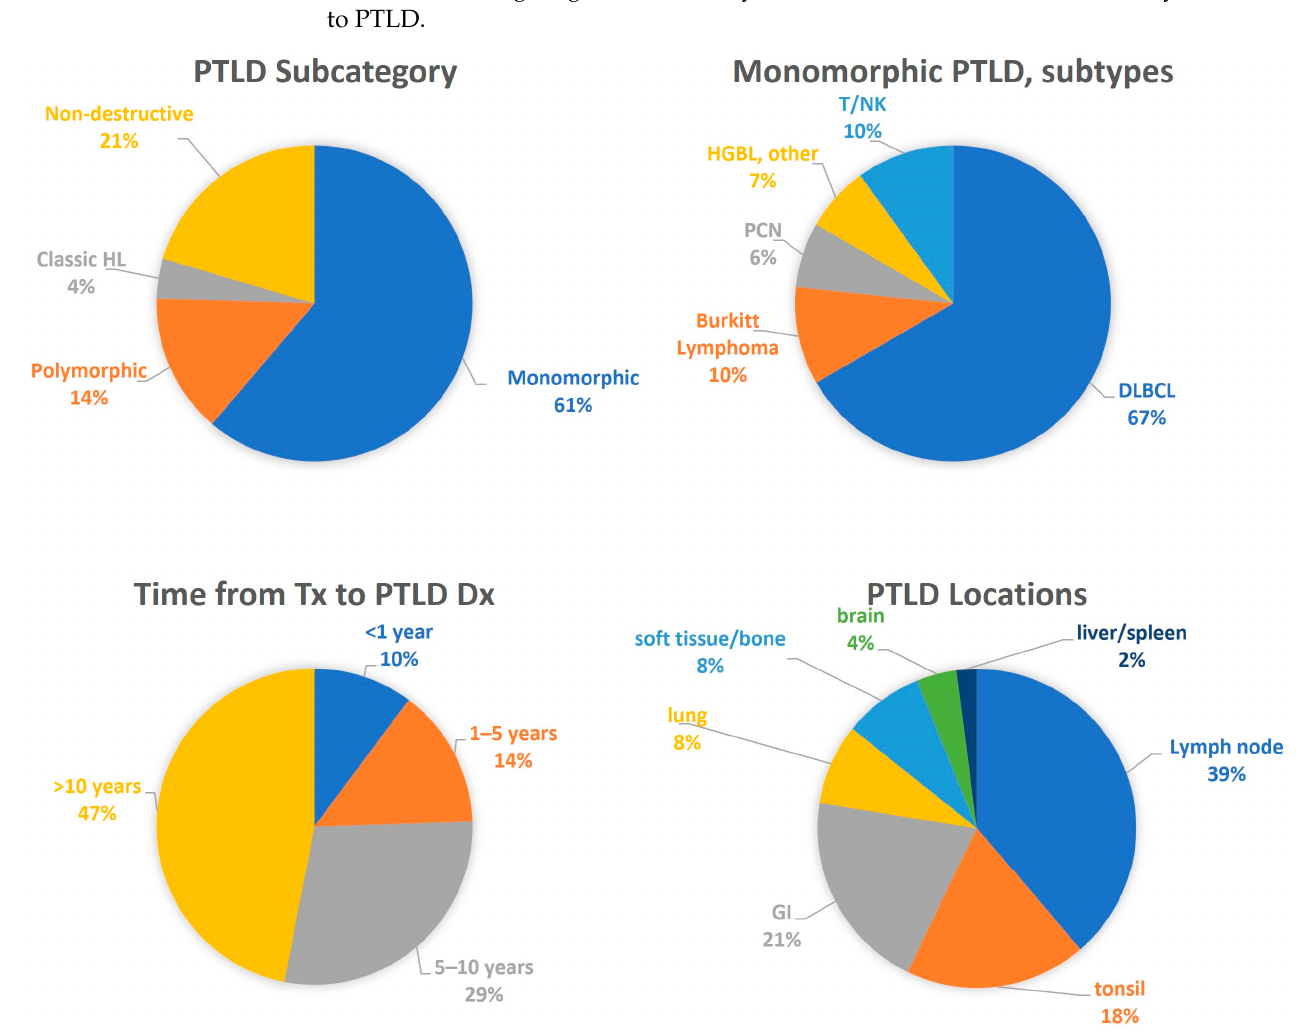
Figure 1. General clinical features in PTLD patients.